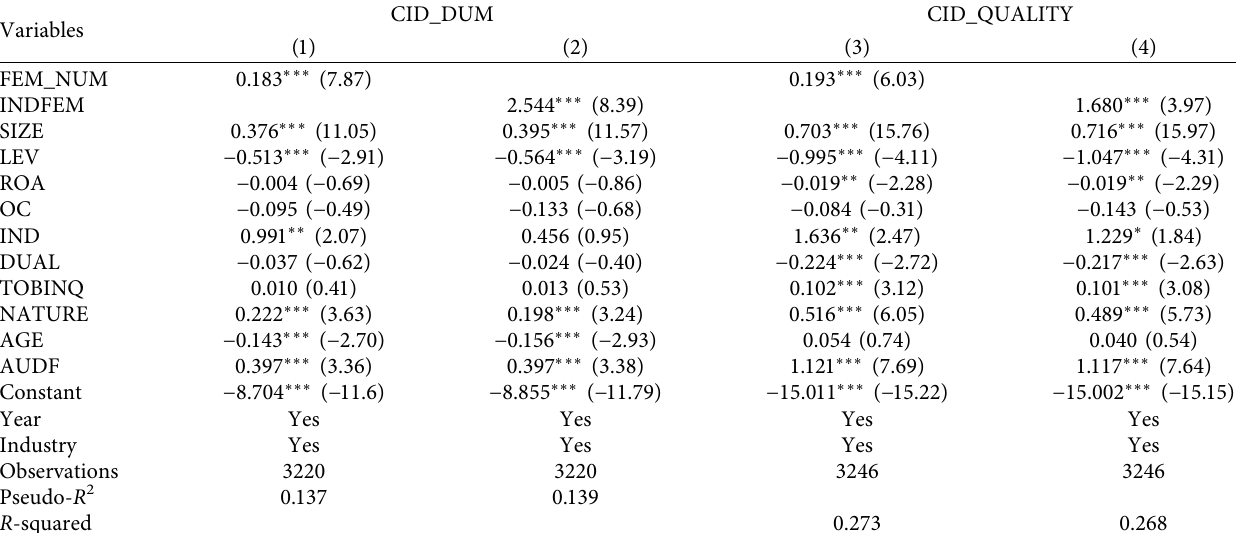
Table 11: Regression results of alternative independent variables.